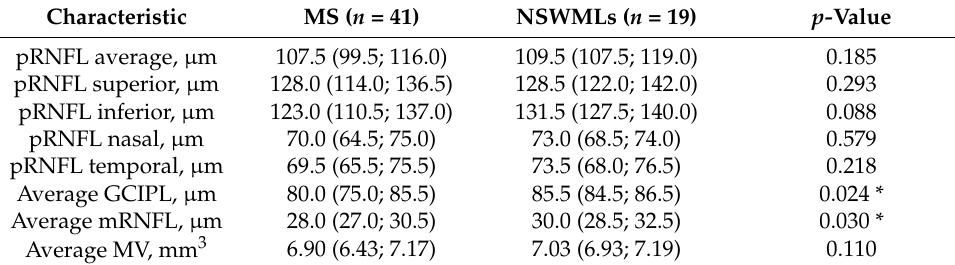
Table 2. Differences in OCT parameters of MS and NSWMLs patients.